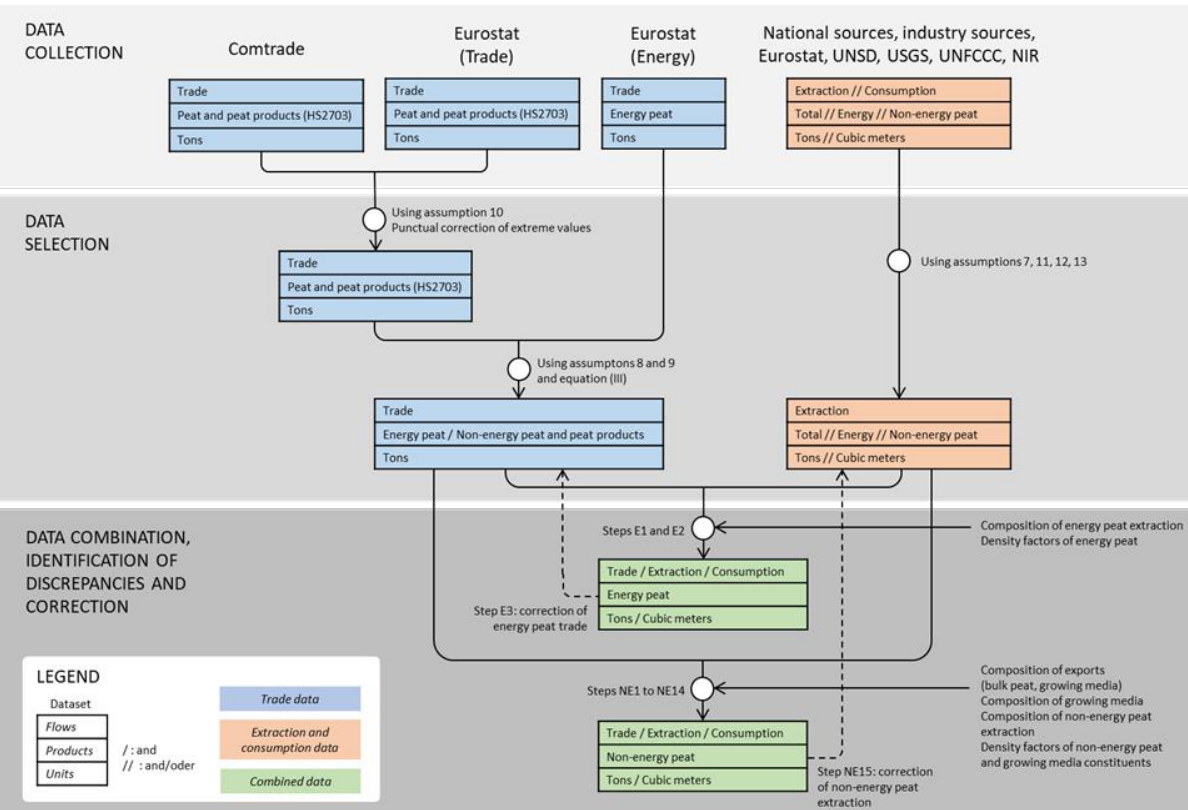
Figure 2. Data collection, selection and